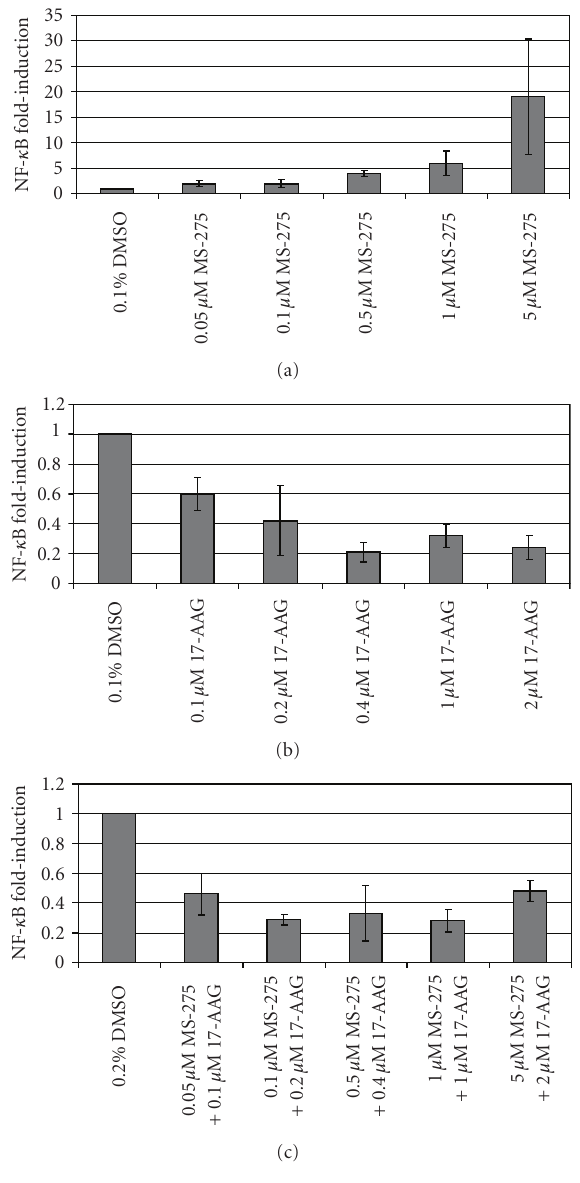
Figure 4: Transcriptional activation of NF- κ B luciferase reporter .